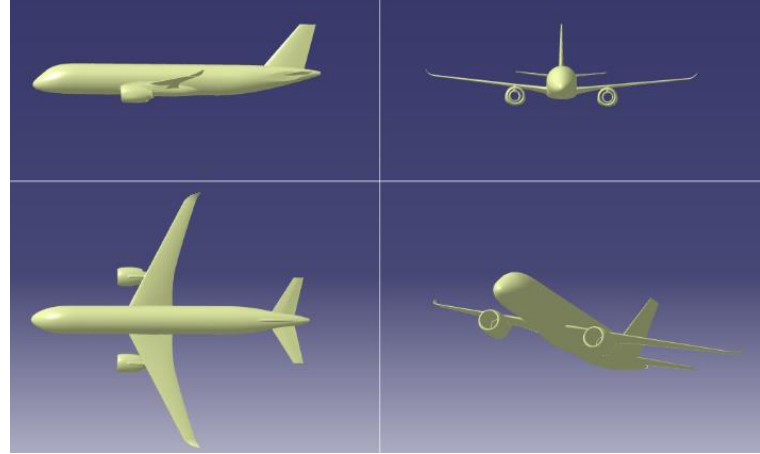
Figure 4. Background plane three-dimensional model three-sided view. The specific parameters of the aircraft are shown in Table 1. c is Average aerodynamic chord length. Table 1. Related parameters of background aircraft.